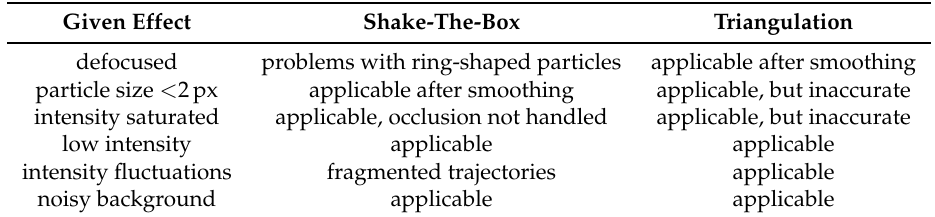
Table 1. Typical particle imaging deficits and their influence on the reconstruction algorithms. “Applicable” indicates that the algorithm can be used without major